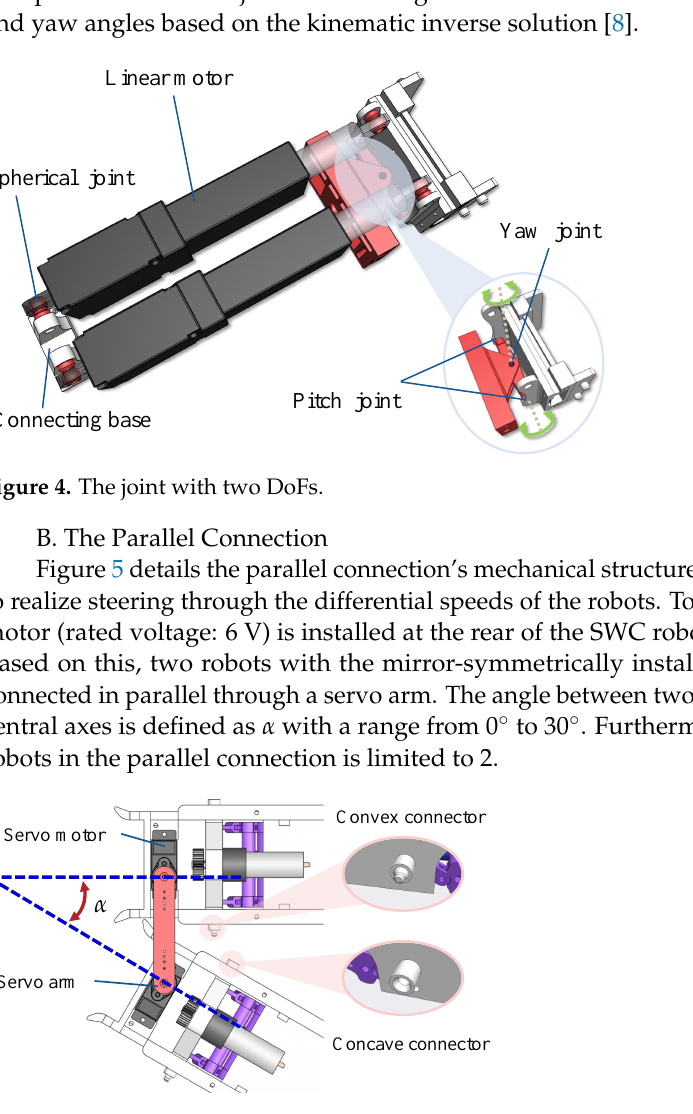
Figure 5. The parallel connection of the SWC